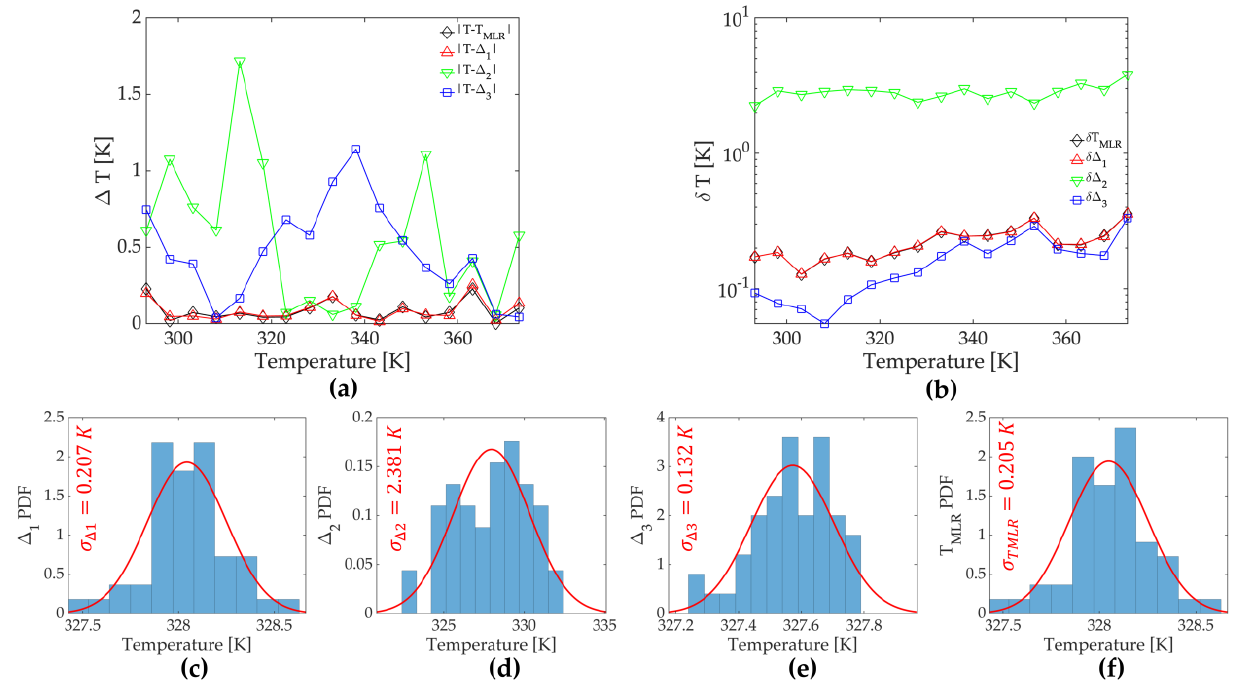
Figure 2. ( a ) The accuracy (Δ T ) and ( b ) the precision (δ T ) of single-parametric ( LIR 1 — red ∆ symbol and line, LIR 2 — green ∇ symbol and line, and E 1E —blue □ symbol and line) and multiparametric temperature (black ♢ symbol and line) readings from the near-infrared emission of Ca 6 BaP 4 O 17 :Mn 5+ at different temperatures; ( c – f ) distributions of temperatures measured by single-parametric ( LIR 1 , LIR 2 , and E 1E ) and multiparametric thermometry, respectively (nominal temperature 328.15 K); temperature distributions were fitted to the normal distribution (red line), and obtained standard deviations are written on graphs (note that a full width at half maximum (FWHM) of distribution can be obtained from a standard deviation as FWHM = 2 ∙ √2 ∙ log⁡(2𝜎) ≈ 2.355𝜎 ).